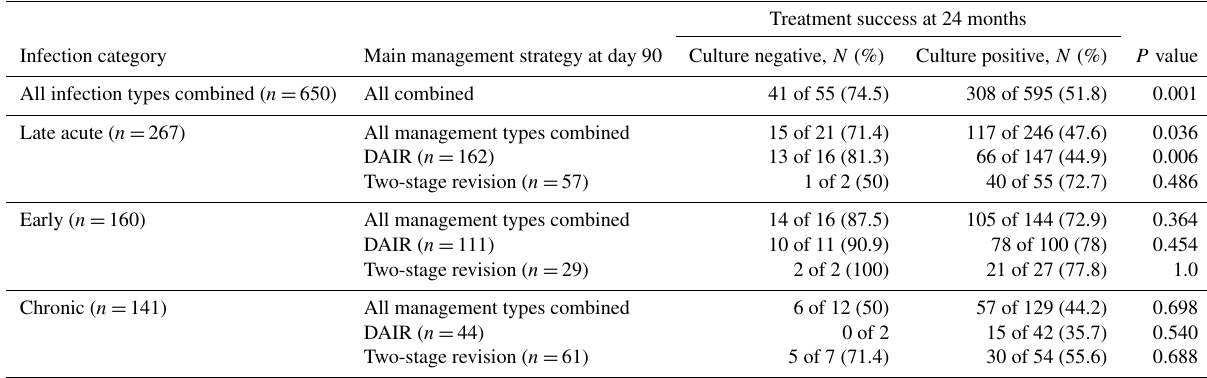
Table 4. Infection type, index surgery, and treatment success in culture-negative and culture-positive prosthetic joint infections.